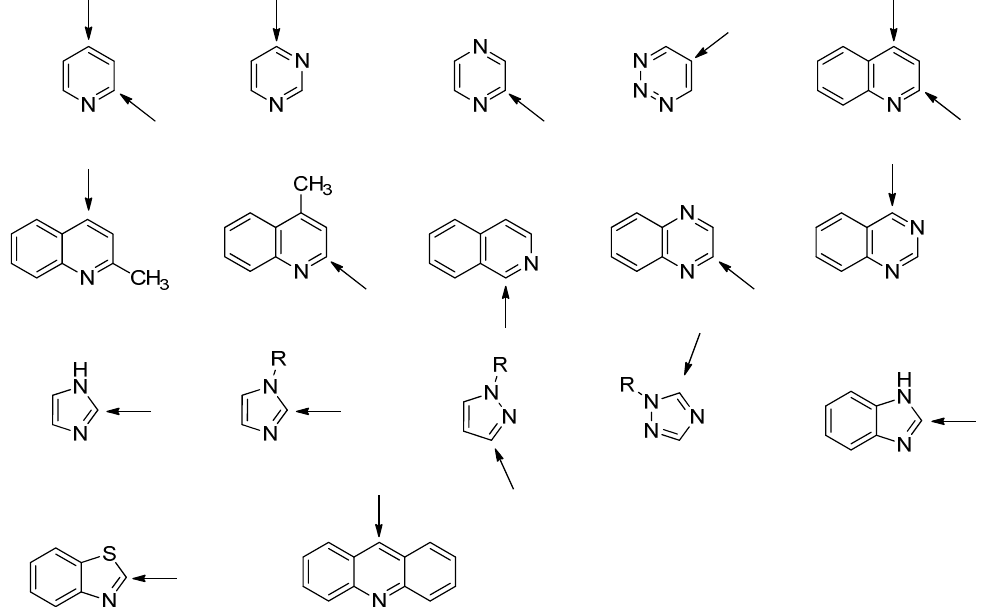
Figure 5. Overview for preferred positions of radical attack to the protonated forms of various heterocyclic